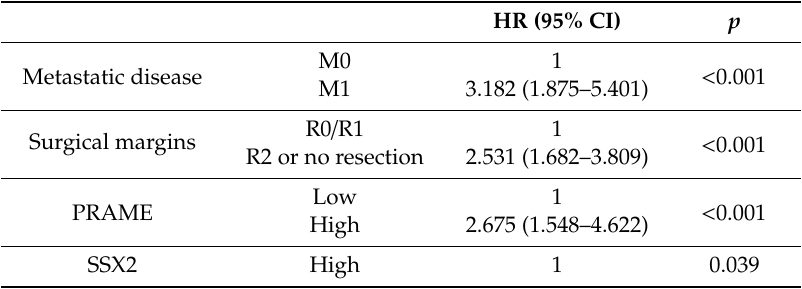
Table 3. Multivariate analysis of overall survival: a Cox proportional hazards model for overall survival was calculated including cancer testis antigens (CTAs) and clinical parameters in a stepwise procedure. HR, hazard ratio. HR (95% CI) p M0 1 < Metastatic disease 0.001 M1 Surgical